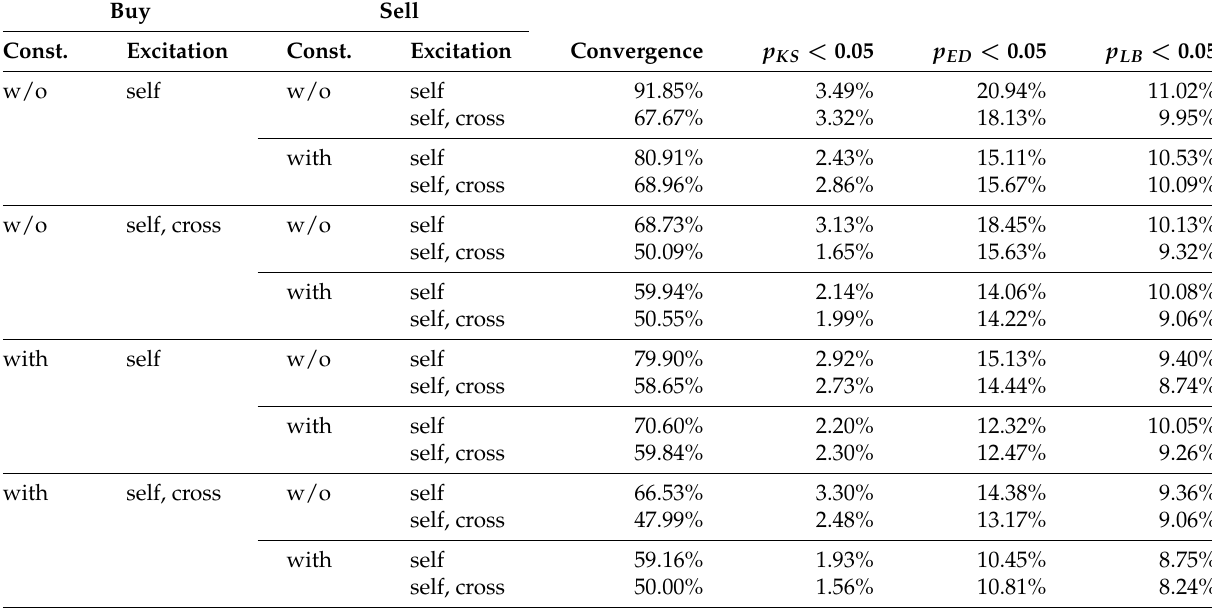
Table 2. Results of goodness-of-fit tests for the pooled processes. The columns “constant” and “excitation” under “buy” specify for buy MOs whether the baseline intensity comprises a constant and the excitation structure, analogously for sell MOs. Each model is estimated 2184 times. The column “convergence” comprises the shares where both the model for buy and sell MOs are estimated successfully. The columns “ p KS < 0.05” and “ p ED < 0.05” comprise the numbers of successfully estimated models in relative terms where the null hypothesis of the KS and ED test is rejected at a 5% significance level, respectively. The column “ p LB < 0.05” comprises the numbers of successfully estimated models in relative terms where the null hypothesis of the LB test for the first five lags is rejected at a 5% significance